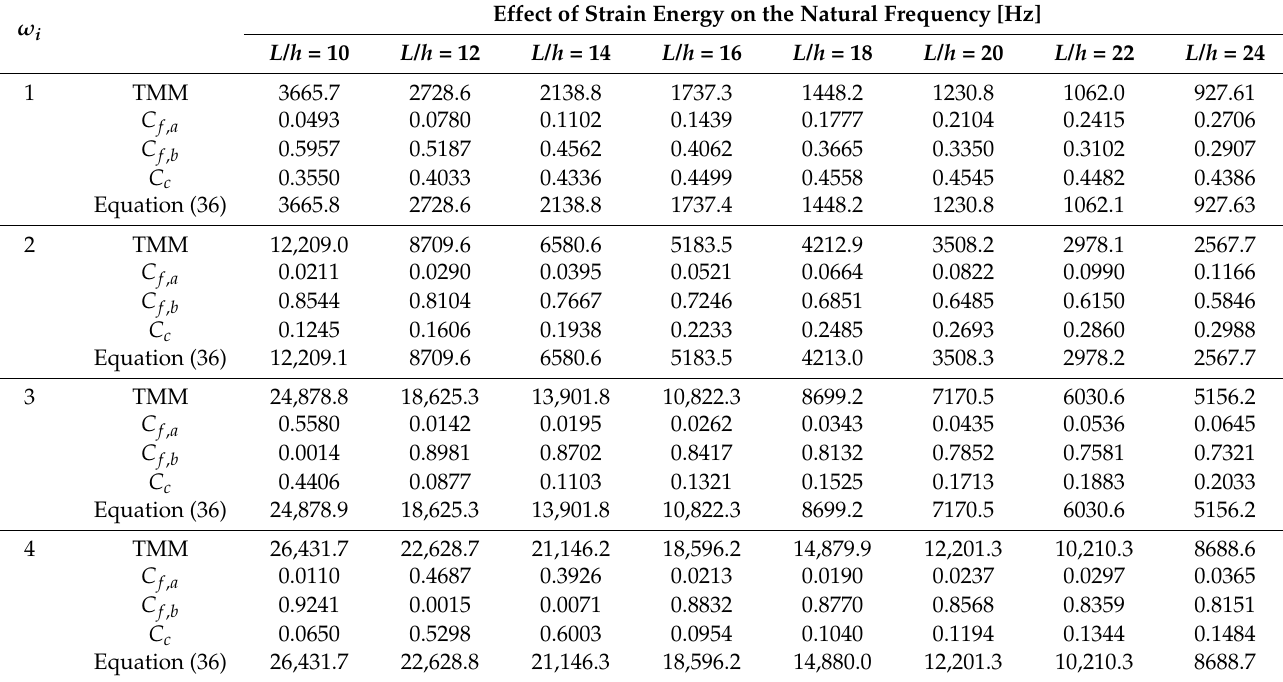
Table 11. Effect of strain energies on the natural frequencies of three-layered beams with the P-P end condition depending on the variation in L/h